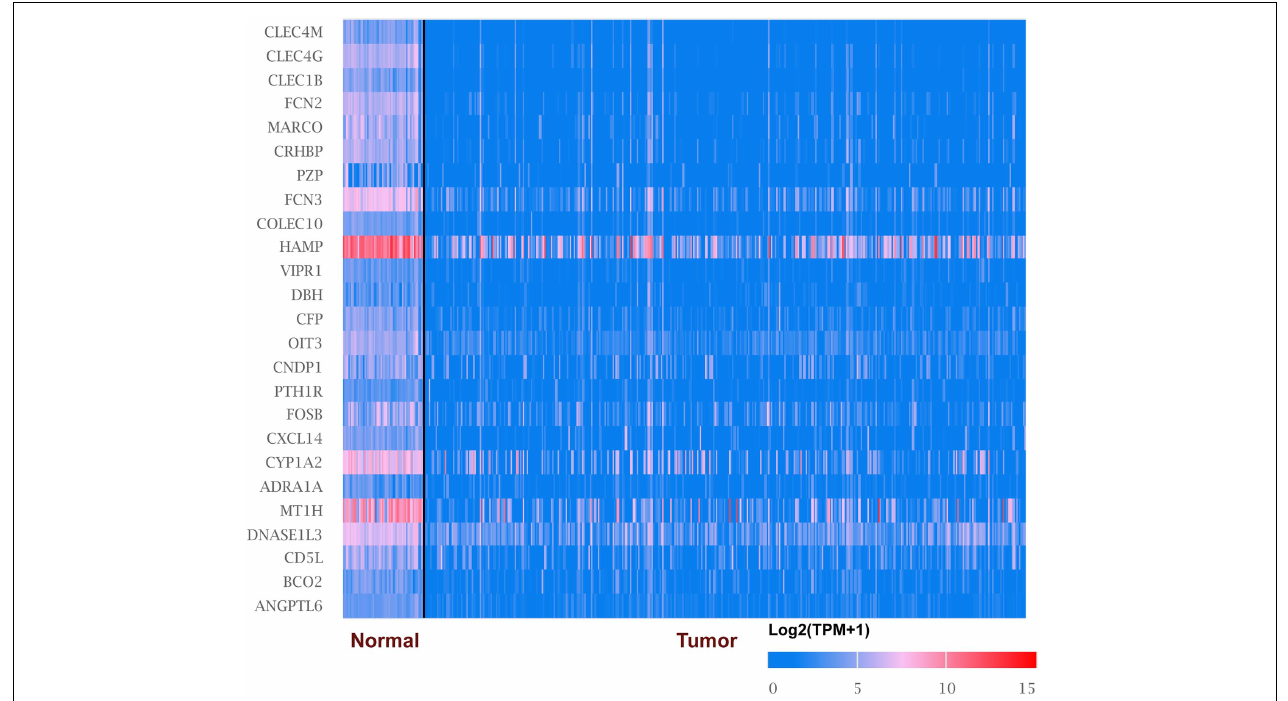
FIGURE 1 | mRNA levels of top 25 under-expressed genes in liver hepatocellular carcinoma (LIHC) (ONCOMINE). The figure shows the numbers of datasets with statistically significant mRNA overexpression (red) or downregulated expression (blue) of genes in LIHC.